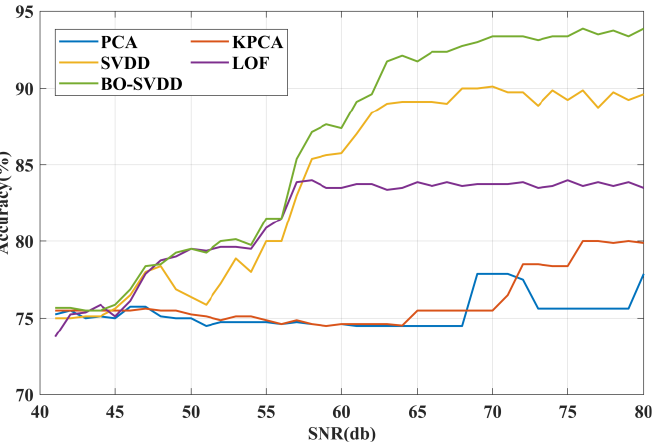
Figure 13. BO-SVDD, SVDD, KPCA, and PCA accuracy test results for the noise test set.